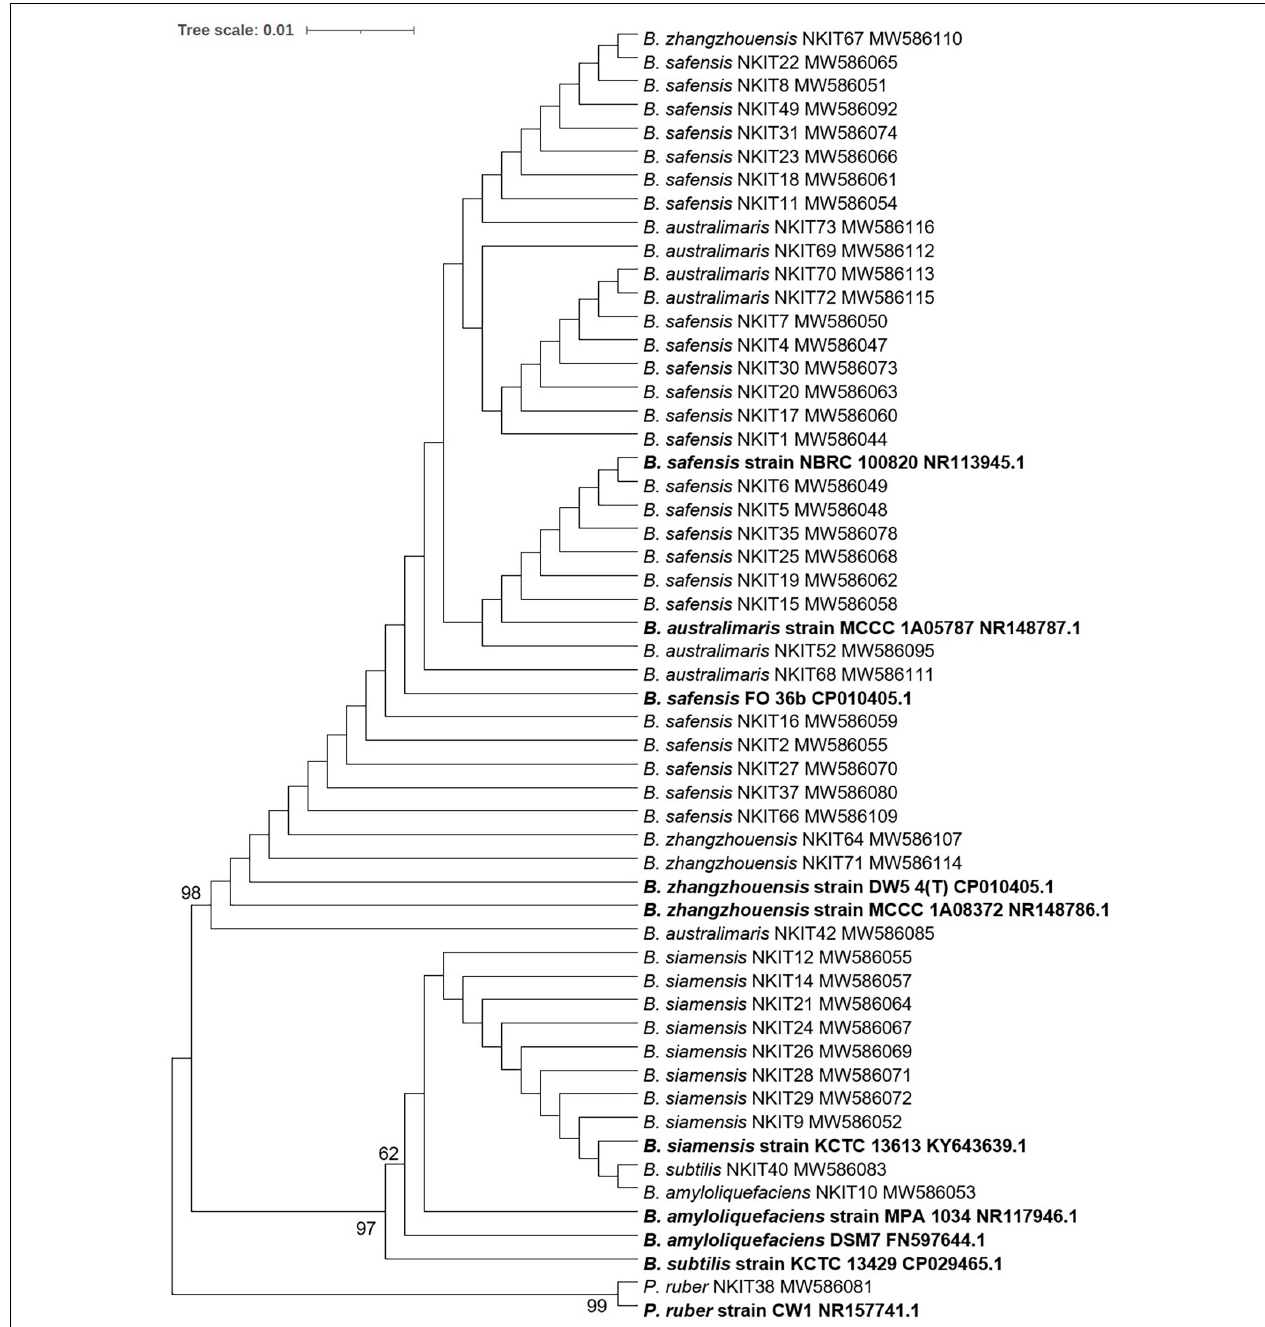
FIGURE 2 | Evolutionary relationships of bacterial isolates investigated in this study: Phylogenetic tree was constructed using 16S rRNA gene sequences and the bootstrap values (100 replicates) are indicated (BS > 50) at the nodes. Closest neighbor of strain NKIT38, Planococcus ruber strain CW1 was used outgroup. The evolutionary history was inferred using the NJ method. The optimal tree with the sum of branch length = 0.07256030 is shown. The evolutionary distances were computed using the Maximum Composite Likelihood method and are in the units of the number of base substitutions per site. The analysis involved 55 nucleotide sequences. All positions containing gaps and missing data were eliminated. There were a total of 545 positions in the final dataset. Evolutionary analyses were conducted in MEGA7.